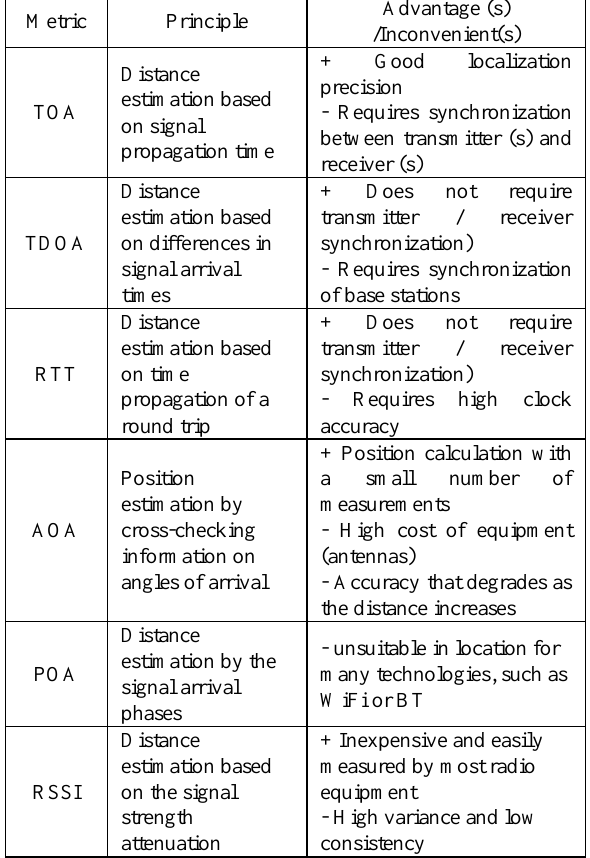
Table 1. Indoor Localization